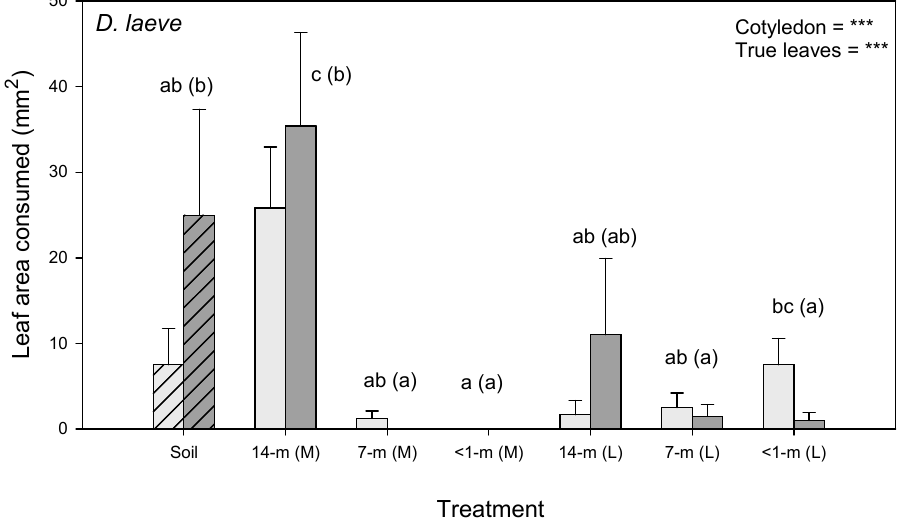
Figure 9. Results from a multichoice bioassay with tomato leaves exposed to D. laeve . Tomato plants were grown in unamended soil (hatched bars), and soil that had 14-, 7- and <1-month-old SCG mixed (M) with soil or added as a layer (L) on top of the soil. Cotyledons (light gray bars) and true leaves (dark gray bars) were exposed during the bioassay without soil. The results of MANOVA are presented for areas consumed from cotyledons and true leaves as *** = p < 0.001. Lowercase letters indicate homogenous treatment groups, with groupings for true leaves in parentheses. Standard errors are indicated (N = 6). Plants grown in each soil type as used in the bioassay are described in Figure 4.